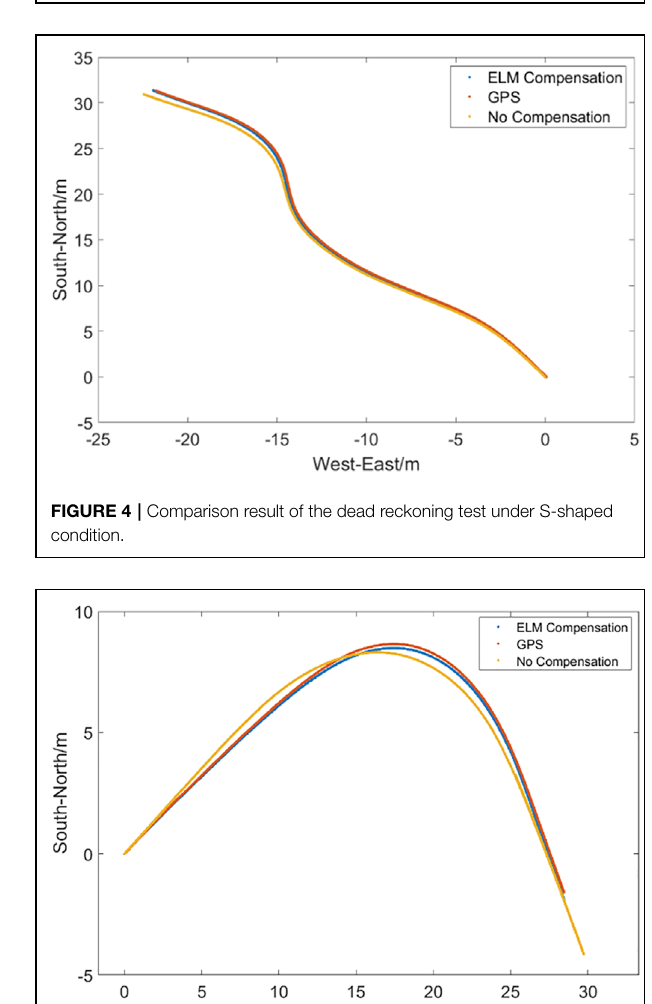
FIGURE 3 | Comparison result of the dead reckoning test under straight line conditions.